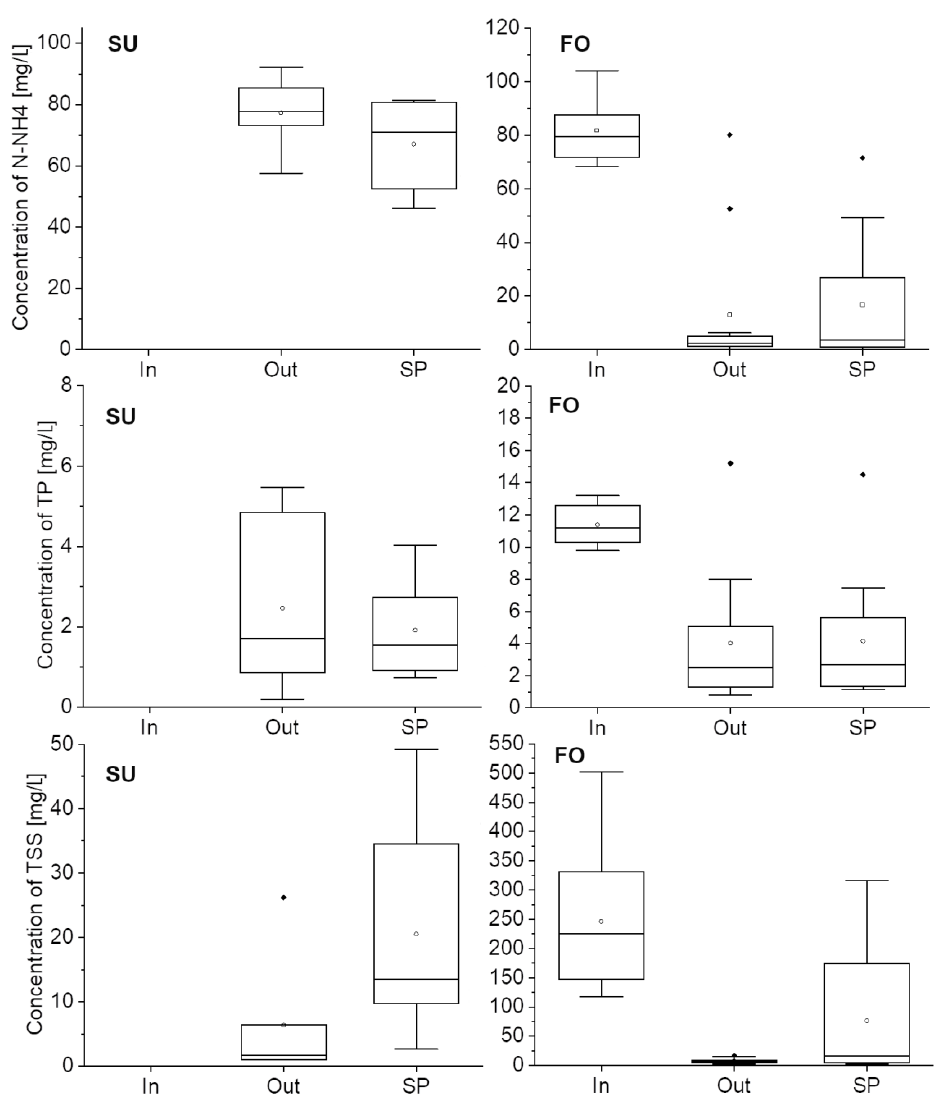
Figure 7. N–NH 4+ , TP and TSS concentration comparison during SU = start-up phase and FO = full-scale operation, In = inlet, Out = outlet, SP = stabilization pond.